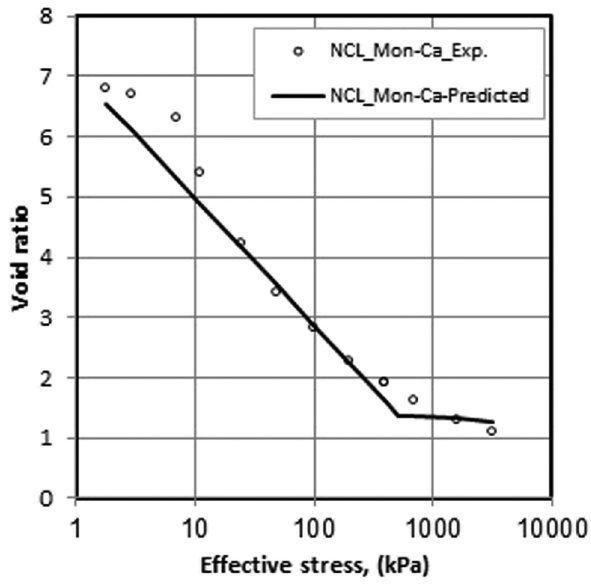
Figure 15: The experimental data and the predicted results of the one - dimensional consolidation tests for the Mon - Ca soil ( experi - mental data from [ 36 ]) .